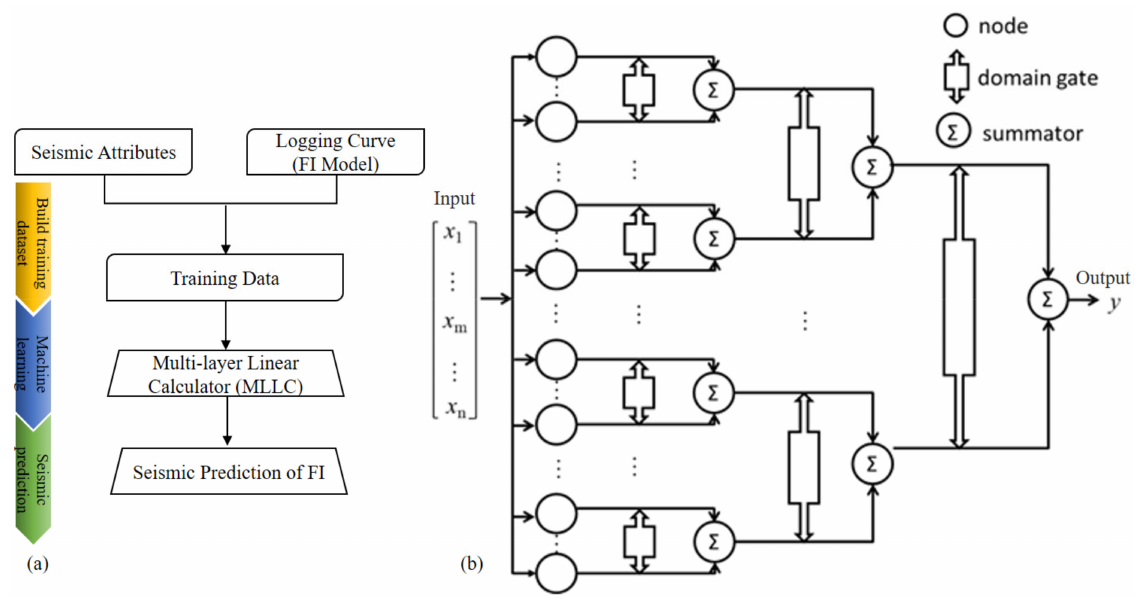
Figure 5. ( a ) The workflow for seismic prediction of FI. ( b ) Structure of multi-layer linear calculator neural